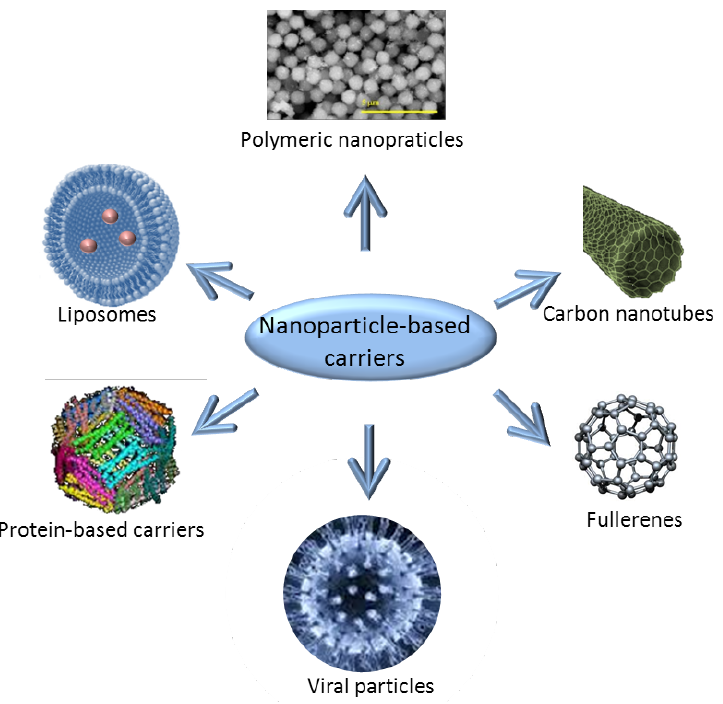
Figure 4. Nanoparticle-based carriers used for targeted drug/gene